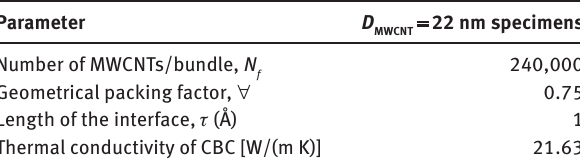
Table 2: The fitting parameters of the Krenchel model.